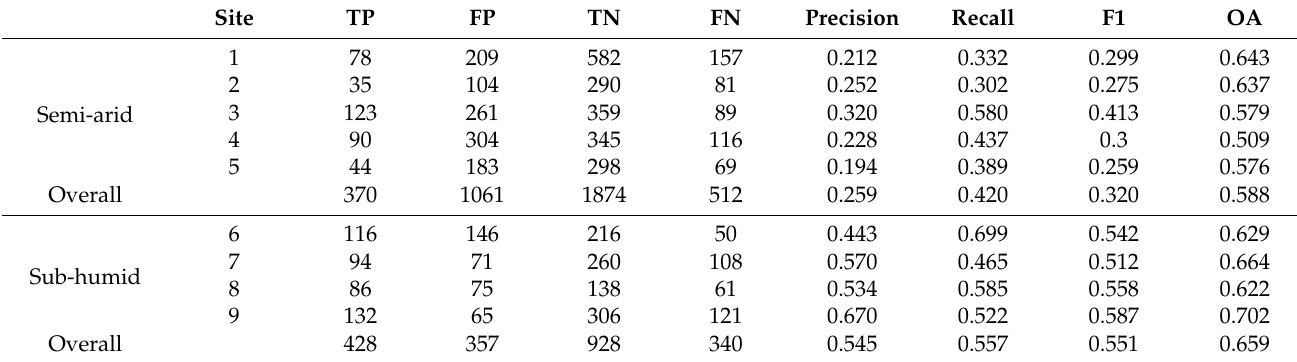
Table 7. Evaluation metrics of olive mapping using single time Planet imagery using CNN.